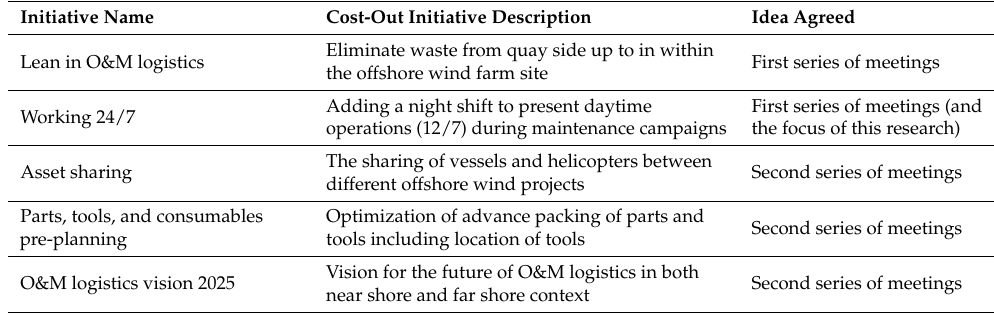
Table 2. The five cost-out initiatives for O&M logistics.